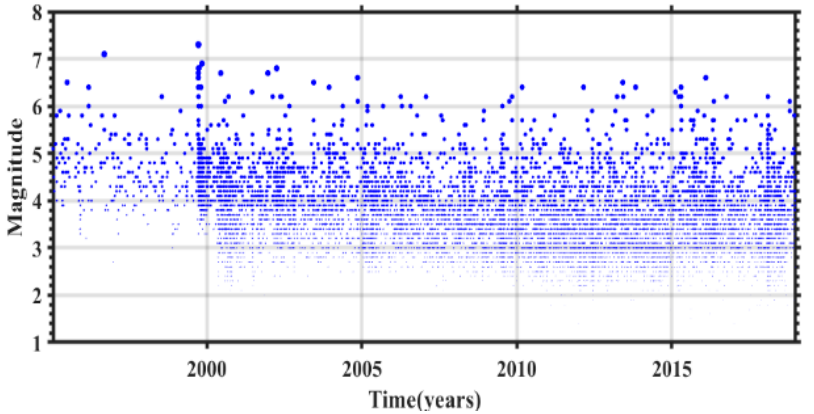
Figure 5. Magnitude distribution as a function of time for earthquakes occurred in the Taiwan region from 1995 to 2019. from 1995 to